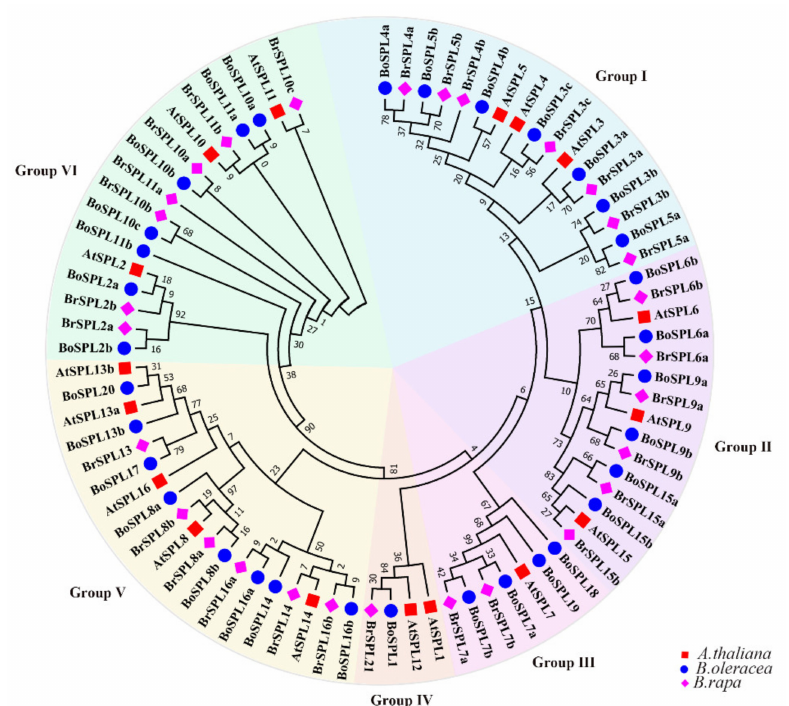
Figure 1. Phylogenetic tree of B. oleracea , B. rapa and A. thaliana SPL proteins. Phylogenetic analysis of 79 SPL proteins from B. oleracea (33), B. rapa (29) and A. thaliana (17) showing similar groups in the three species. Six groups were marked with different background